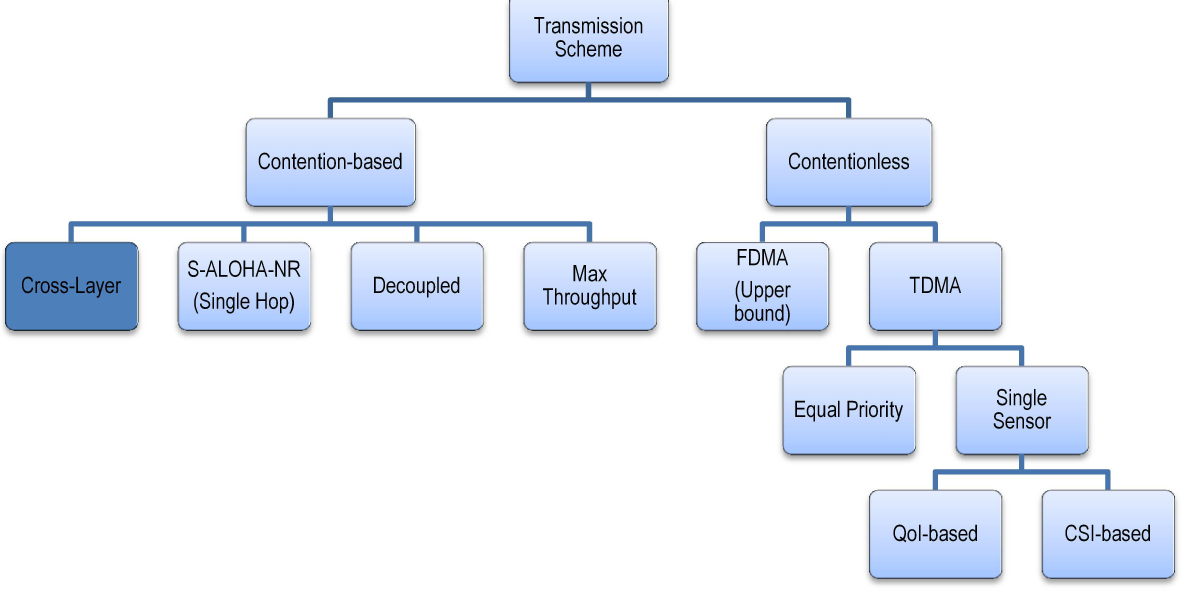
Figure 9. Transmission schemes for performance comparison.